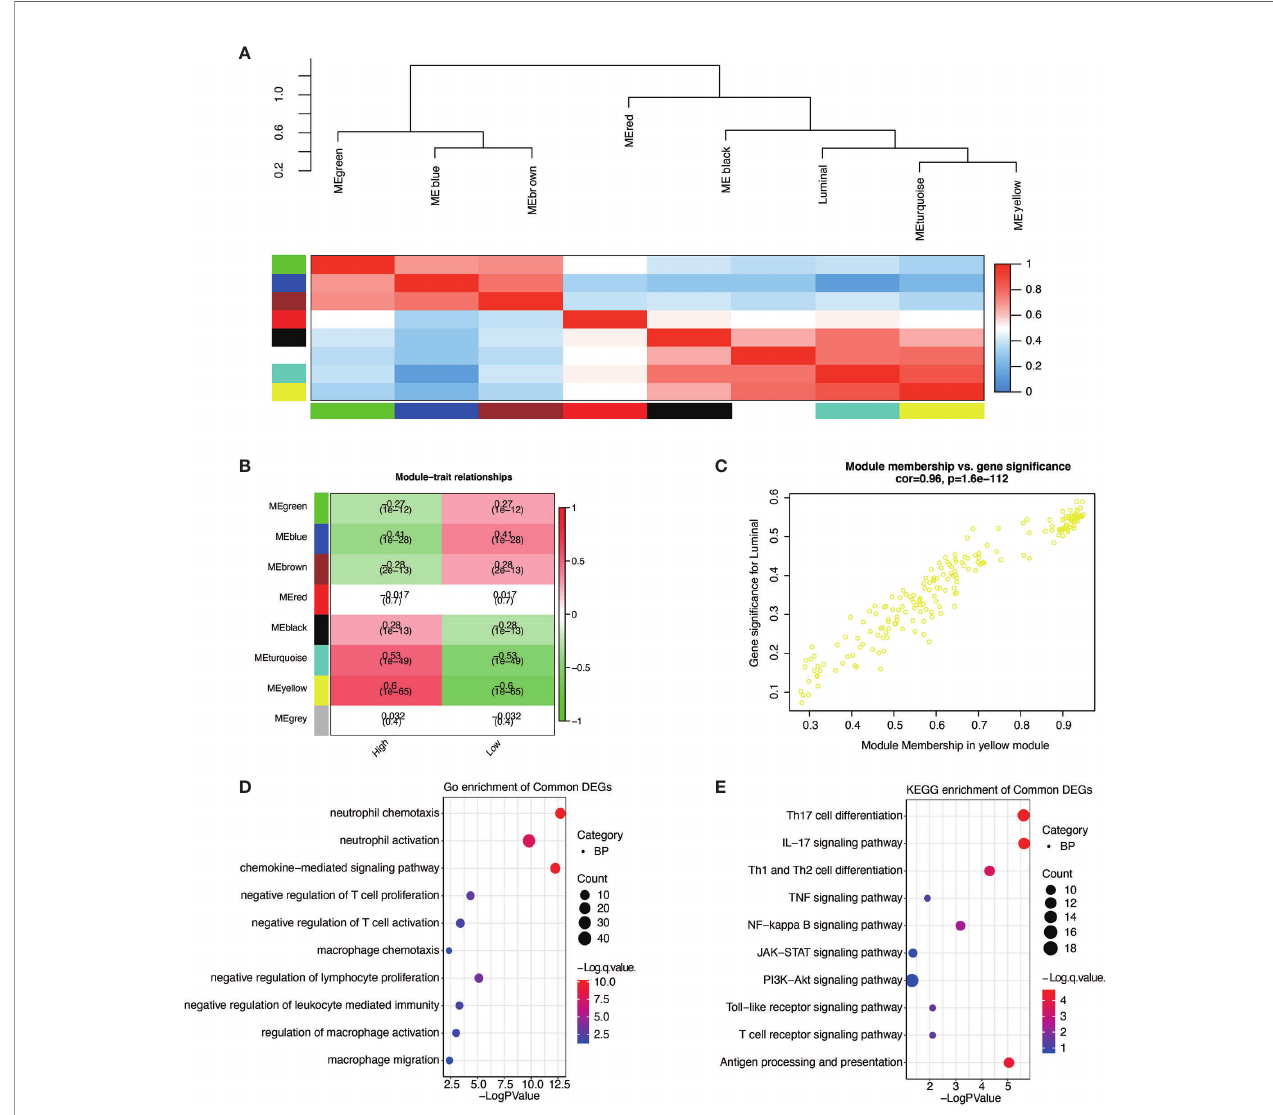
FIGURE 9 | Higher expression of APOBEC3B related gene signature identi fi cation. (A) WGCNA was applied to identify the clustered eigengene modules. (B) Seven modules are identi fi ed by WGCNA. (C) The yellow module has the highest correlation (r = 0.96, P = 1.6e-112). (D) Go analysis was performed based on APOBEC3B high related genes. (E) KEGG analysis was performed based on APOBEC3B high related